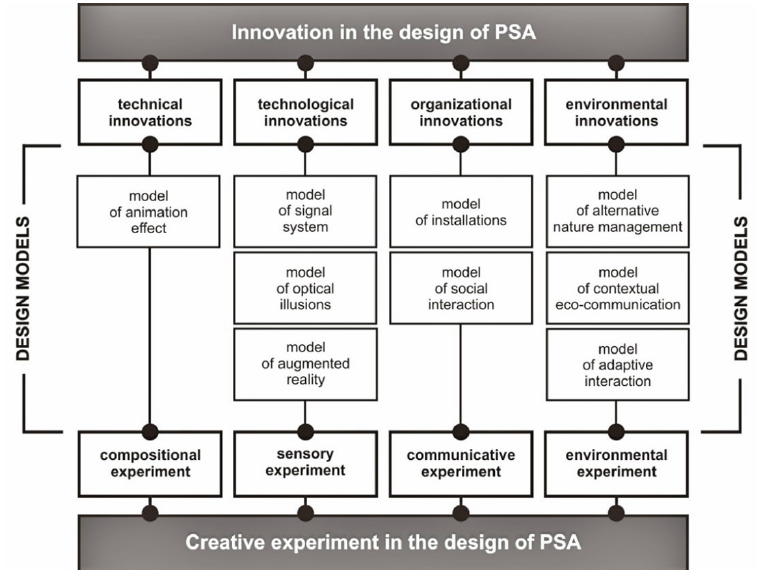
Figure 1. Classification of innovations in public service announcement and their experimental basis (source: created by